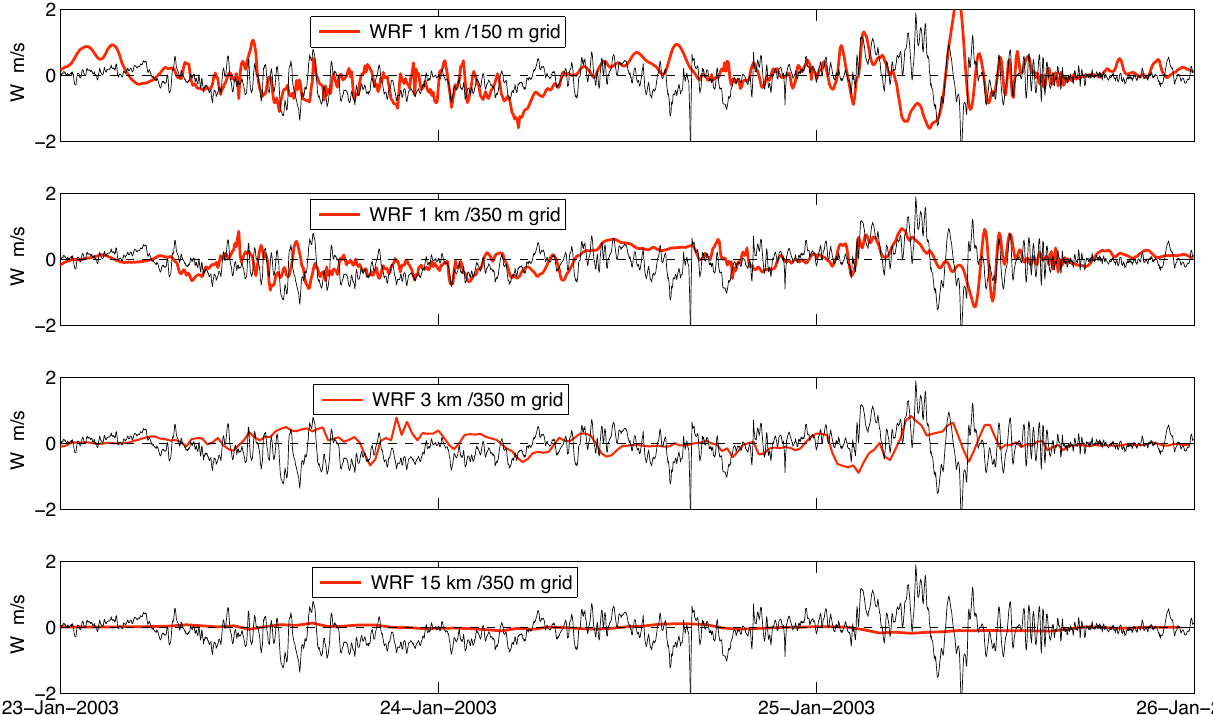
Fig. 8. Comparison between vertical wind velocities measured by ESRAD and WRF model results using different horizontal (1, 3 or 15km) and vertical (150 or 350m) resolutions. Measurements and model results at 3000m